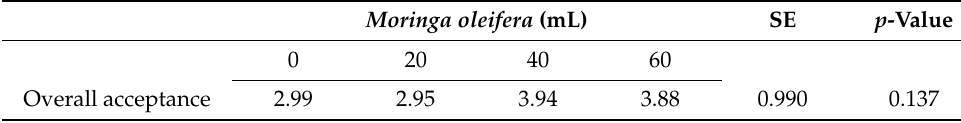
Table 3. Overall acceptance of yogurt from sheep fed with Moringa oleifera extracts. Moringa oleifera